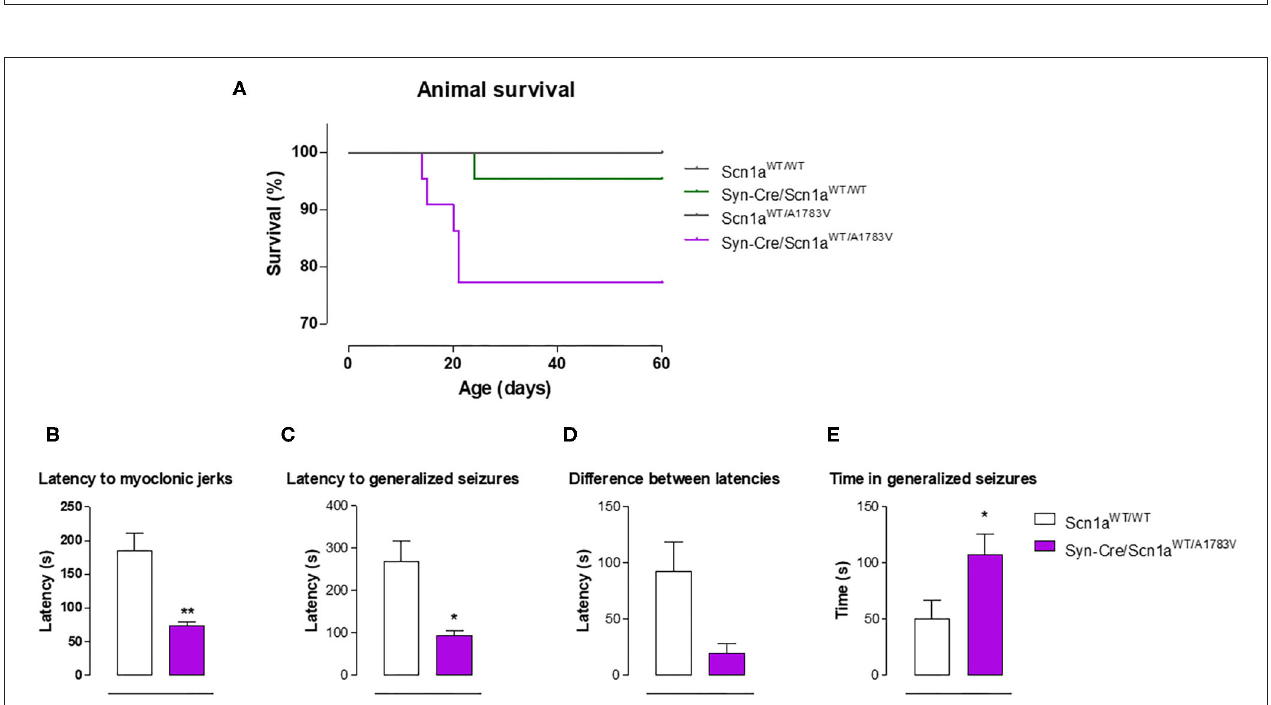
FIGURE 4 | Evolution of different behavioral parameters recorded in the elevated plus maze (upper panels) and in the social interaction test (lower panels) in Syn-Cre/Scn1a WT / A1783V mice and their three control groups (Scn1a WT / WT , Syn-Cre/Scn1a WT / WT , and Scn1a WT / A1783V mice) measured at different postnatal days in the range PND25–PND60. Values are means ± SEM of 11–21 animals per group. Data were assessed by using two-way ANOVA for repeated measures followed by the Bonferroni test (* p < 0.05, ** p < 0.01, *** p < 0.005 vs. control groups; # p < 0.05 vs. Scn1a WT / WT group).